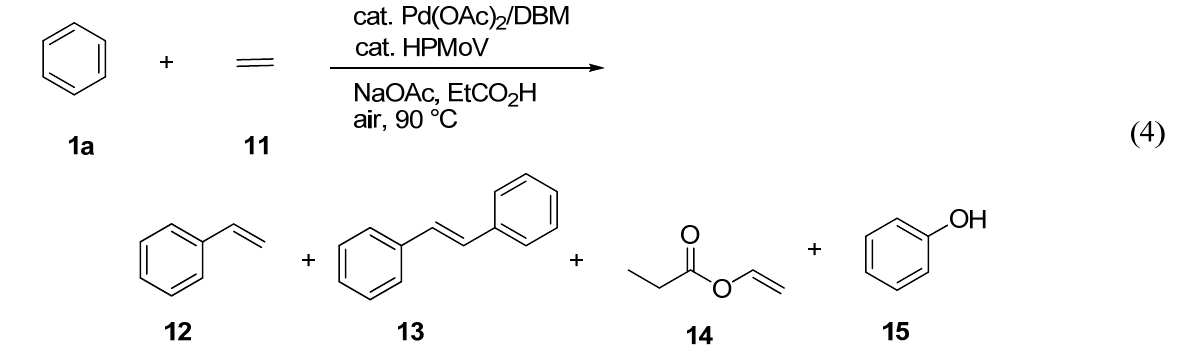
Table 5. Oxidative coupling of benzene ( 1a ) with ethylene ( 11 ) catalyzed by Pd(II)/HPMoV. a